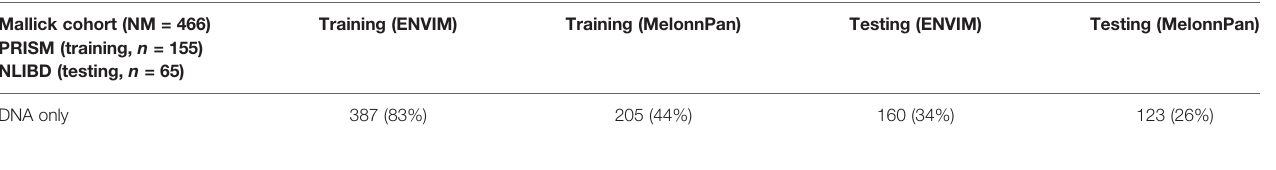
TABLE 3 | Prediction results in Mallick data, when using all samples in the PRISM study as the training set and the data in NLIBD study as the testing set. Mallick cohort (NM = 466) PRISM (training, n = 155) NLIBD (testing, n =